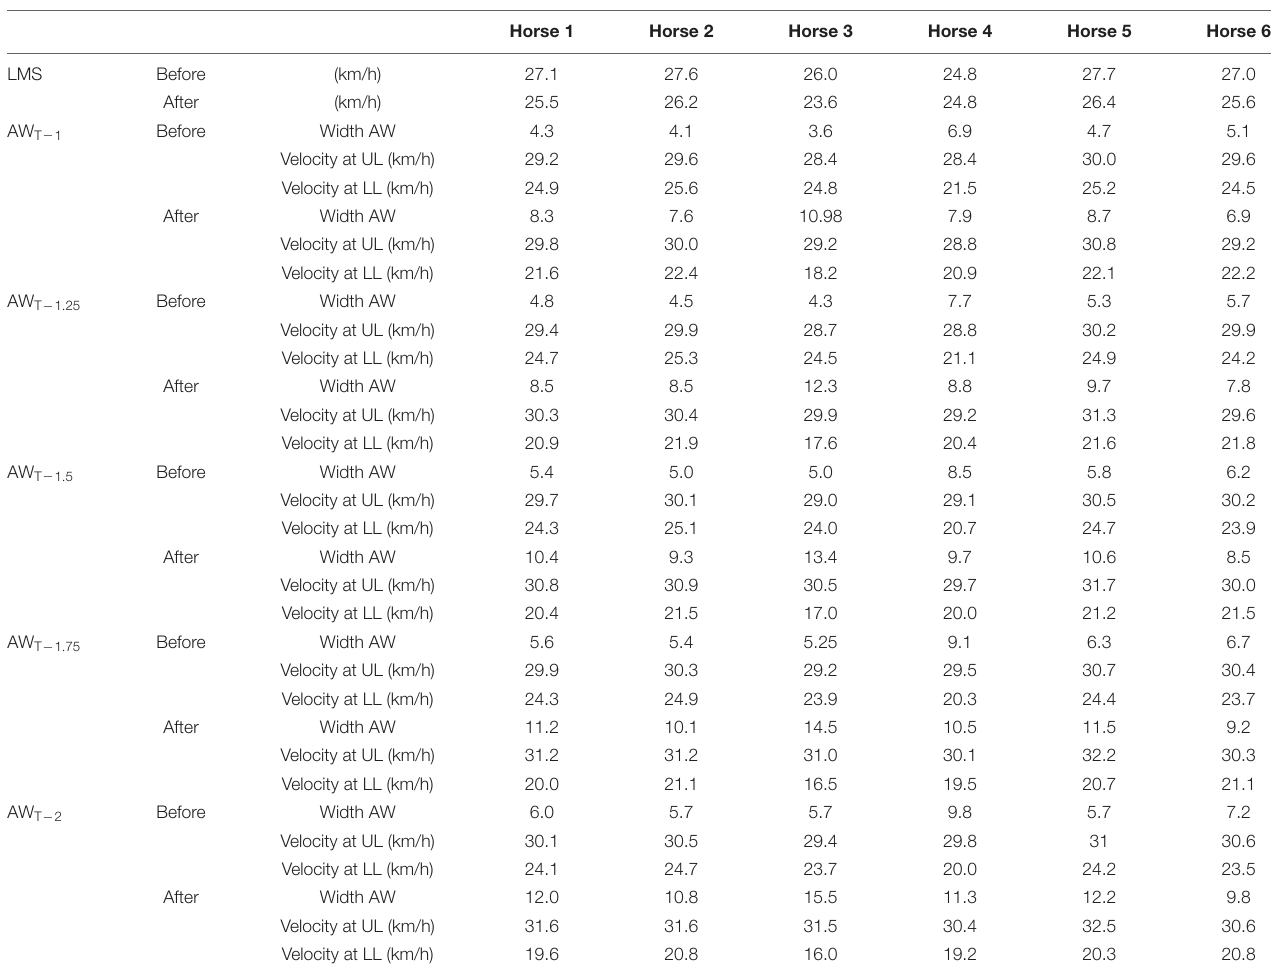
TABLE 5 | Assessment of the width of the aerobic window (UL minus the LL) of each horse, by means of the threshold approach (AW T ) at blood lactate concentration of respectively 1/1.25/1.5/1.75 and 2 mmol/L. Horse 1 Horse 2 Horse 3 Horse 4 Horse 5 Horse